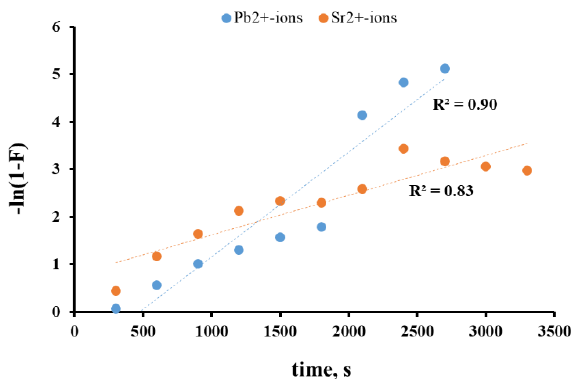
Figure 4. Change of −ln(1− F ) coefficient for metal ion sorption on PPT.